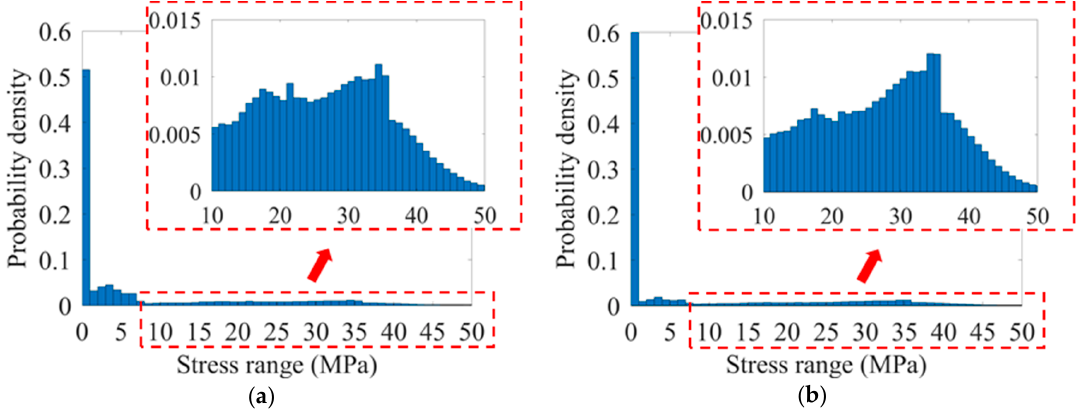
Figure 15. Stress spectra in terms of hot spot stress: ( a ) critical detail D1 and ( b ) critical detail D2.